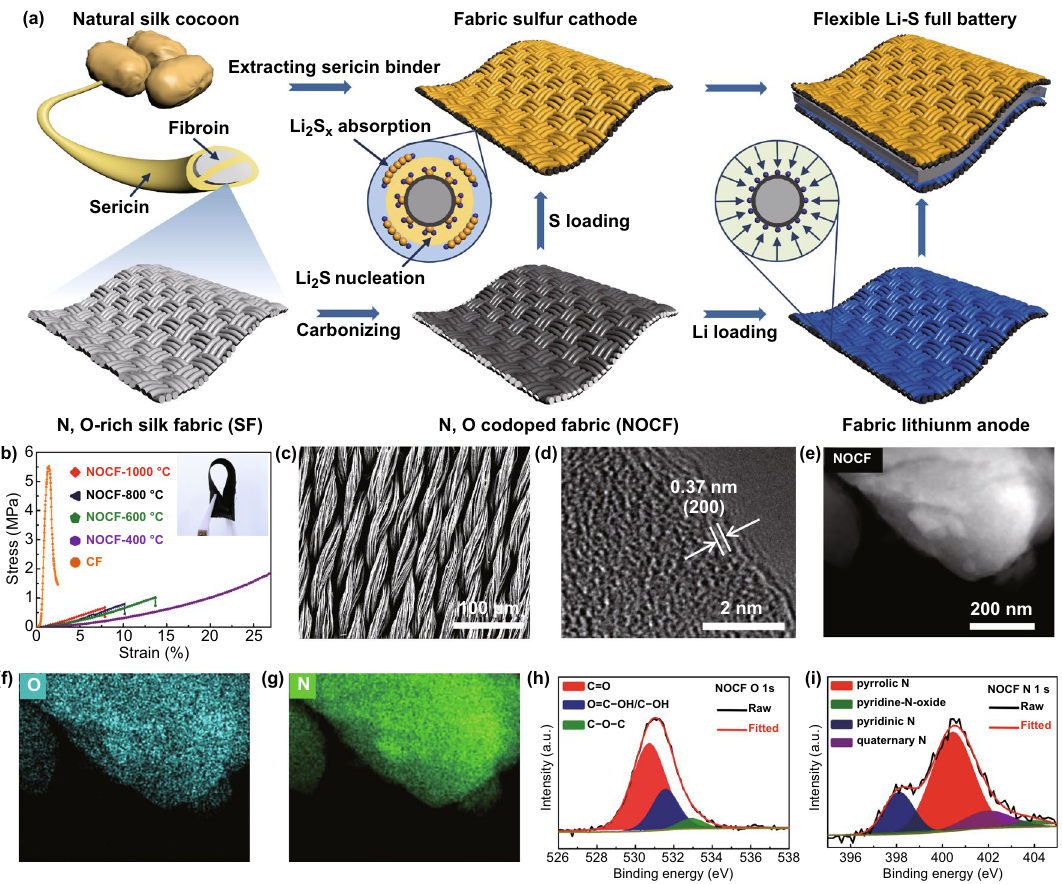
Fig. 1 a Illustration of the manufacturing process and design principle of flexible Li–S full batteries. The N/O-codoped carbonized fabric (NOCF) with high flexibility, high conductivity, and abundant N/O-codoped sites is synthesized by the gradient carbonization of natural silk fabric under an inert atmosphere. Subsequent to the thermal carbonization of silk fibroin, a certain amount of Li metal was electroplated onto NOCF to yield the Li/NOCF anode and a slurry mixture containing sericin protein (SP) binder, Ketjen black, and S was coated onto NOCF to yield the SP/S/NOCF cathode. b Tensile stress–strain curves of CF and NOCFs at various annealing temperatures (inset shows the optical image of optimal NOCF at 1000 ℃ ). c Scanning electron microscopy (SEM) image of the optimal NOCF. d High-resolution transmission electron microscopy (TEM) image of the optimal NOCF. e–g Low-resolution TEM image ( e ) and energy-dispersive X-ray spectroscopy (EDS) elemen- tal mapping ( f , g ) of the optimal NOCF. h , i High-resolution X-ray photoelectron spectroscopy (XPS) spectra of O 1 s and N 1 s of the